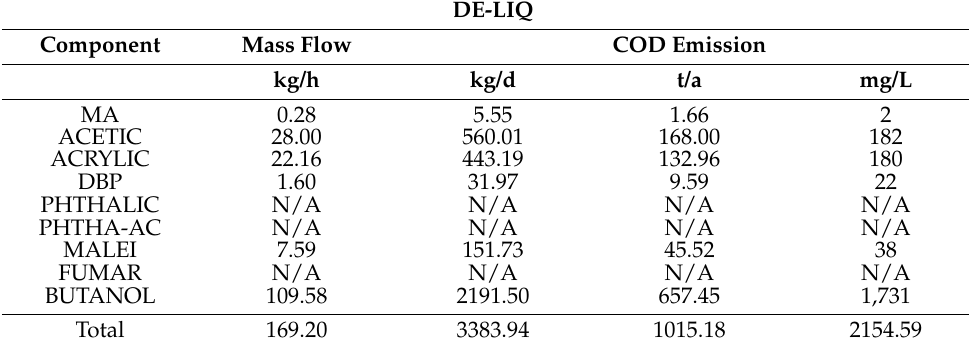
Table 9. Calculation of DE-LIQ stream COD.